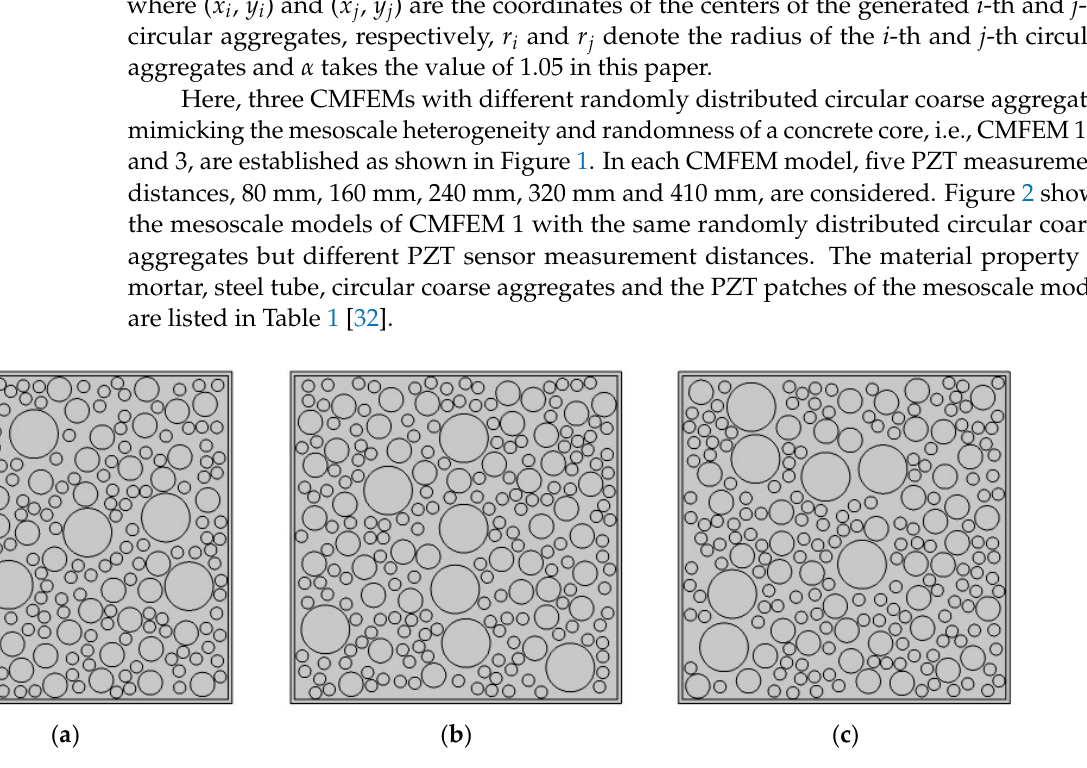
Figure 1. Mesoscale concrete core in RCFSTs using RAM. ( a ) CMFEM 1; ( b ) CMFEM 2; ( c ) CMFEM 3.